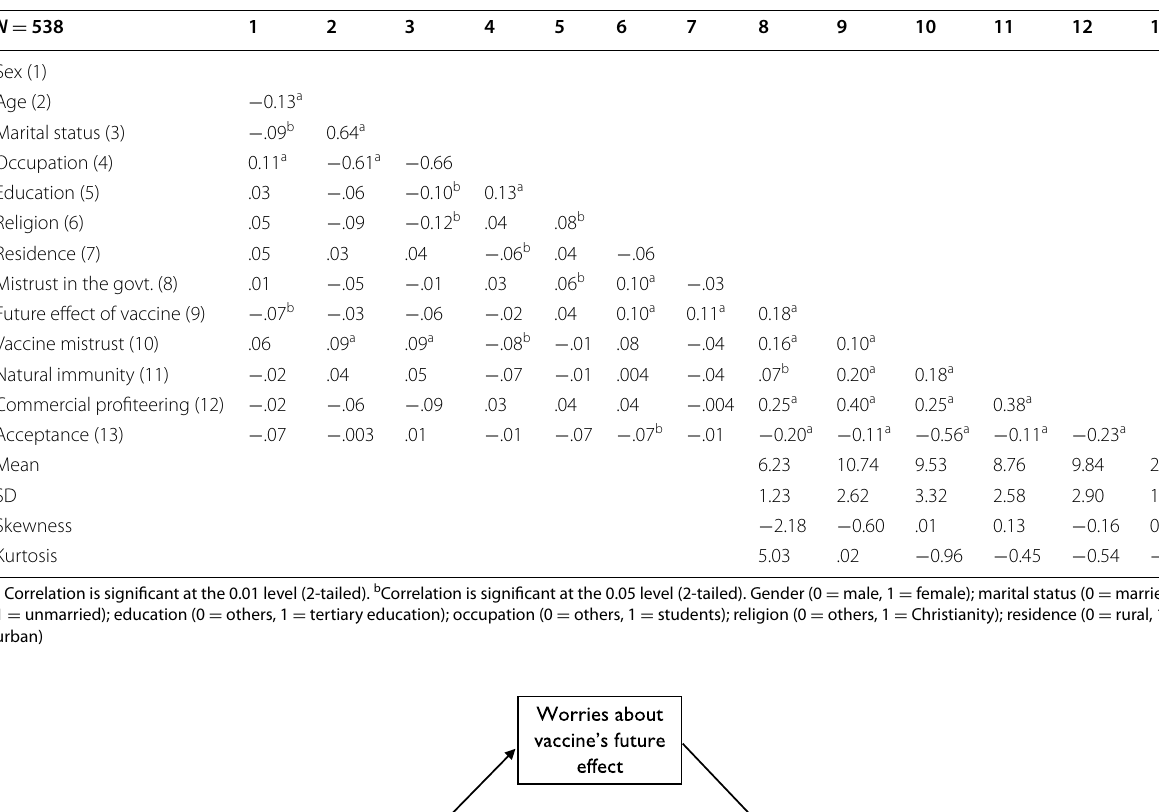
Table 3 Bivariate correlations and descriptive